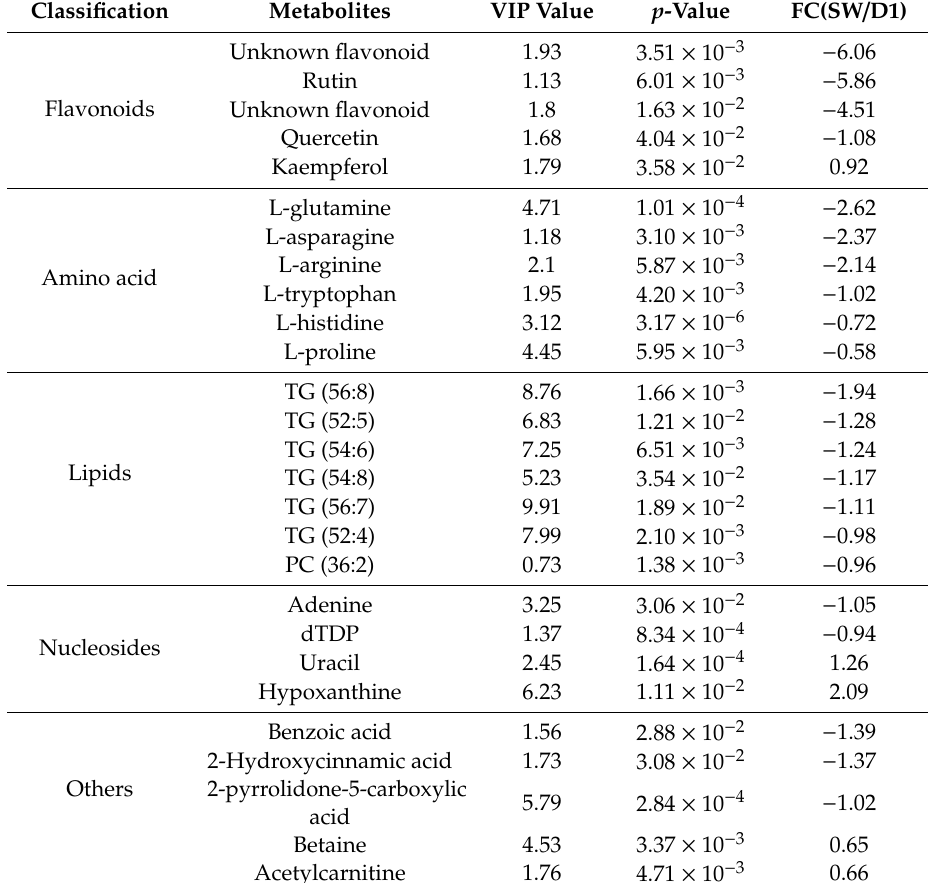
Table 2. Di ff erential metabolites between groups (healthy silkworm samples (SW) vs. di ff erent sti ff time sample